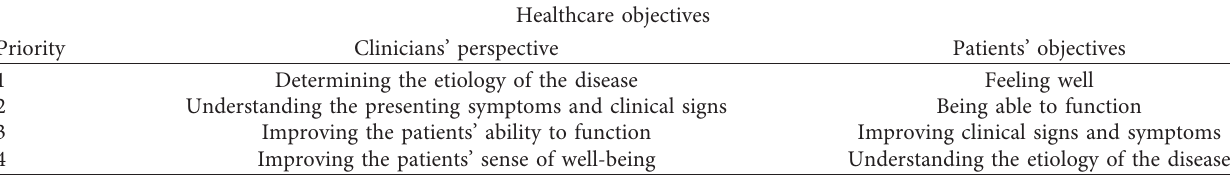
Table 2: Healthcare objectives from clinicians and patients’ perspectives (adapted from Kvale [62]).